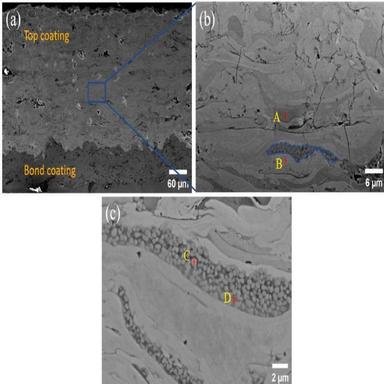
(a) Cross-sectional SEM micrograph of the niobium carbide composite coating, (b) high magnification of (a), (c) high magnification of NbC fine-grains region.